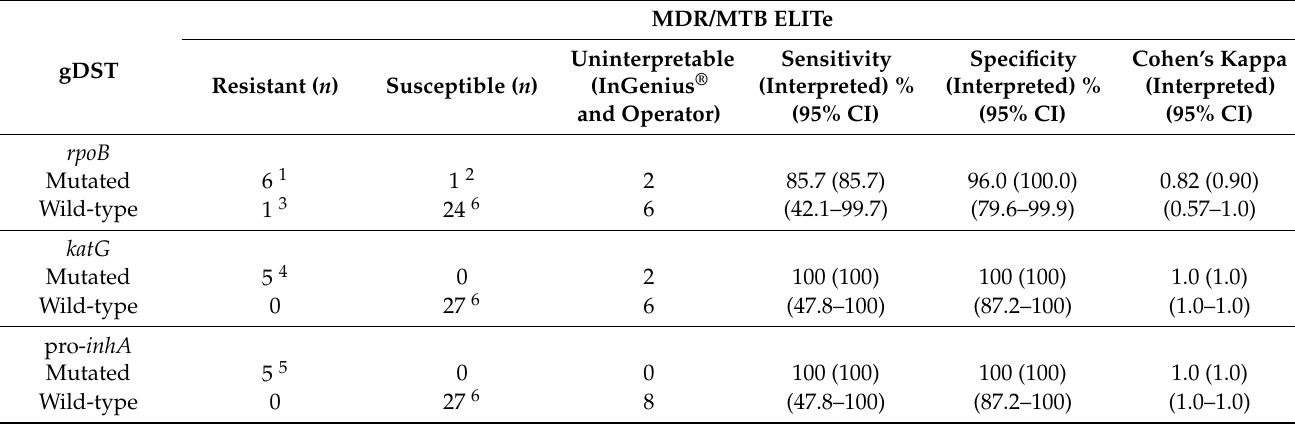
Table 2. Performances of MDR/MTB ELITe MGB ® assay in detecting resistance mutations in rpoB , katG , and pro- inhA on 40 ELITe MTB-positive specimens in comparison with